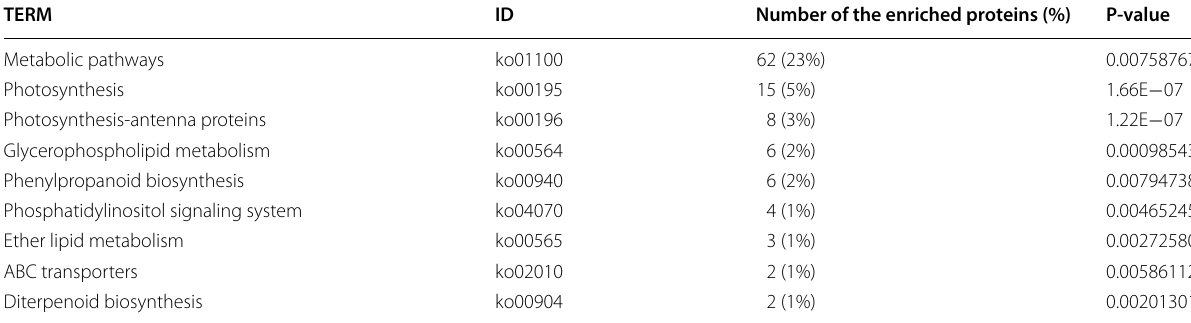
Table 2 KEGG pathway enrichment for the downregulated DCPs TERM ID Number of the enriched proteins